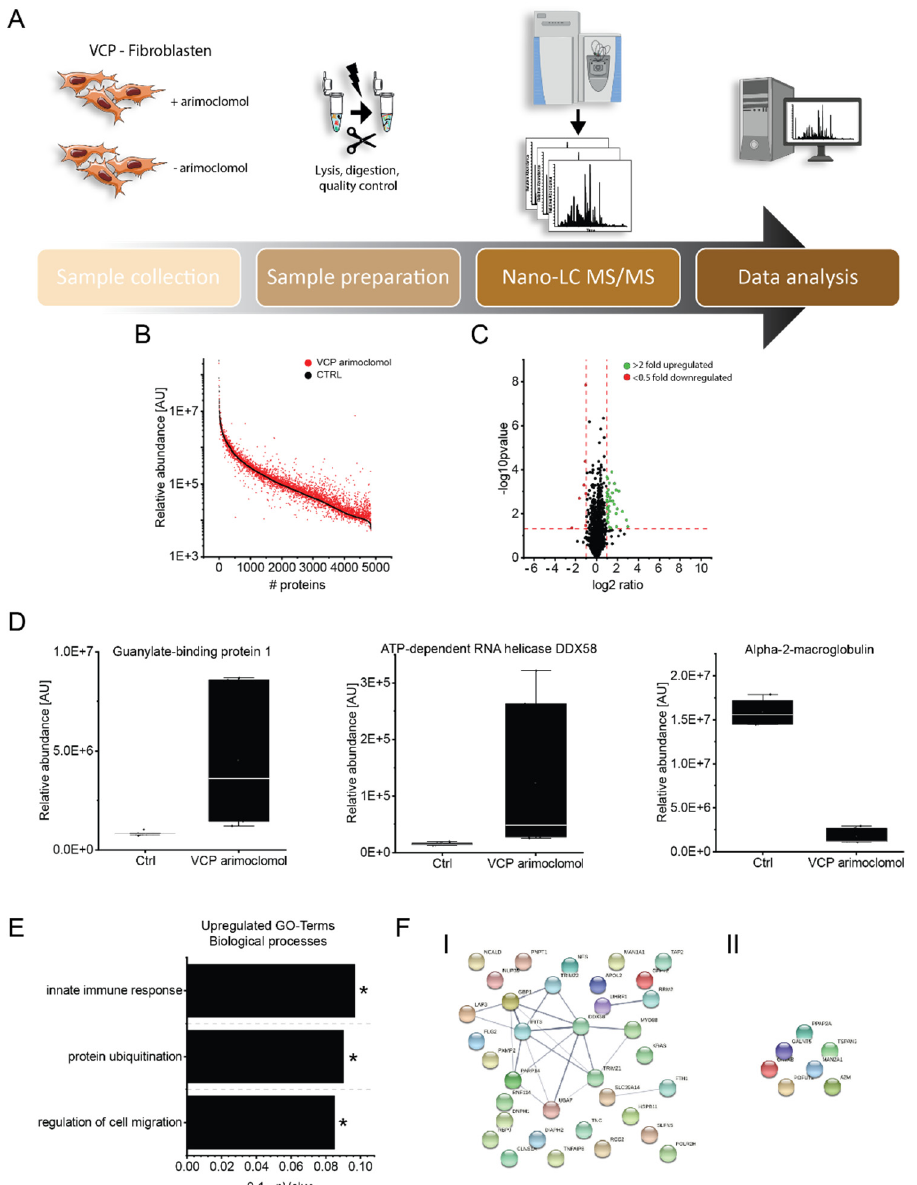
Figure 4. Effect of arimoclomol treatment on proteostasis of VCP –mutant fibroblasts analyzed by proteomic profiling. ( A ) Workflow applied to biochemically address the effect of arimoclomol on proteostasis of VCP –patient derived fibroblasts. ( B ) Abundance plot showing the dynamic range of all identified proteins based on their relative quantification using always the 3 highest abundant peptides for each protein, allowing protein comparison within an experiment. All identified proteins of the control (black) are sorted with decreasing abundance while the patient (red) was plotted in the same order to directly compare the different abundances. All identified proteins cover a dynamic range of eight orders of magnitude. ( C ) Volcano plot highlighting statistically significant increased proteins (green dots) as well as decreased proteins (red dots). ( D ) Box plots of selected dysregulated proteins showing the increase of GBP1, DDX58 as well as decrease of A2MG upon arimoclomol exposure in VCP –mutant fibroblasts. ( E ) Results of the GO–term based analysis of affected biological processes based on proteins identified with increased abundance upon arimoclomol treatment of VCP –mutant fibroblasts. * indicates a p -value ≤ 0.05.( F ) STRING network analysis of dysregulated proteins separated according to increased (I) and decreased (II).